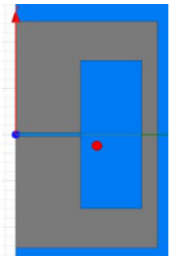
Figure 5. Axisymmetric representation (cylindrical coordinates) of AWG24 round conductors in an RM6 core with an air gap.